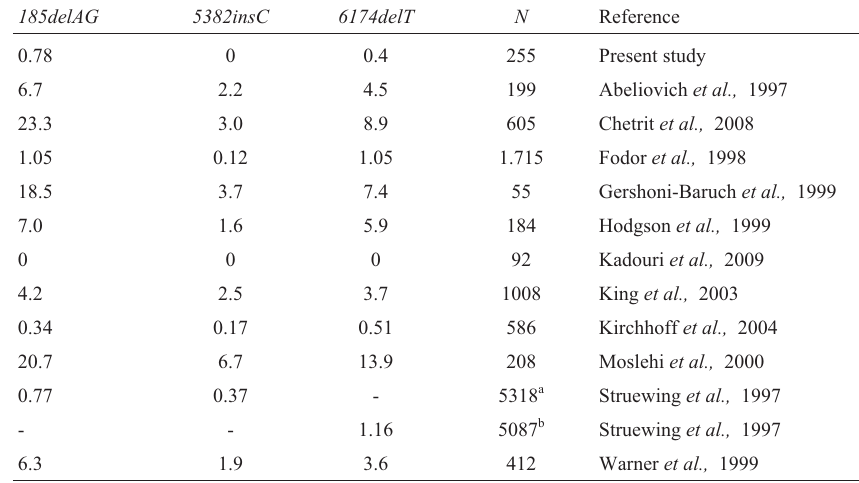
a : Number of patients tested for BRCA1 (185delAG and 5382insC). b : Number of patients tested for BRCA2